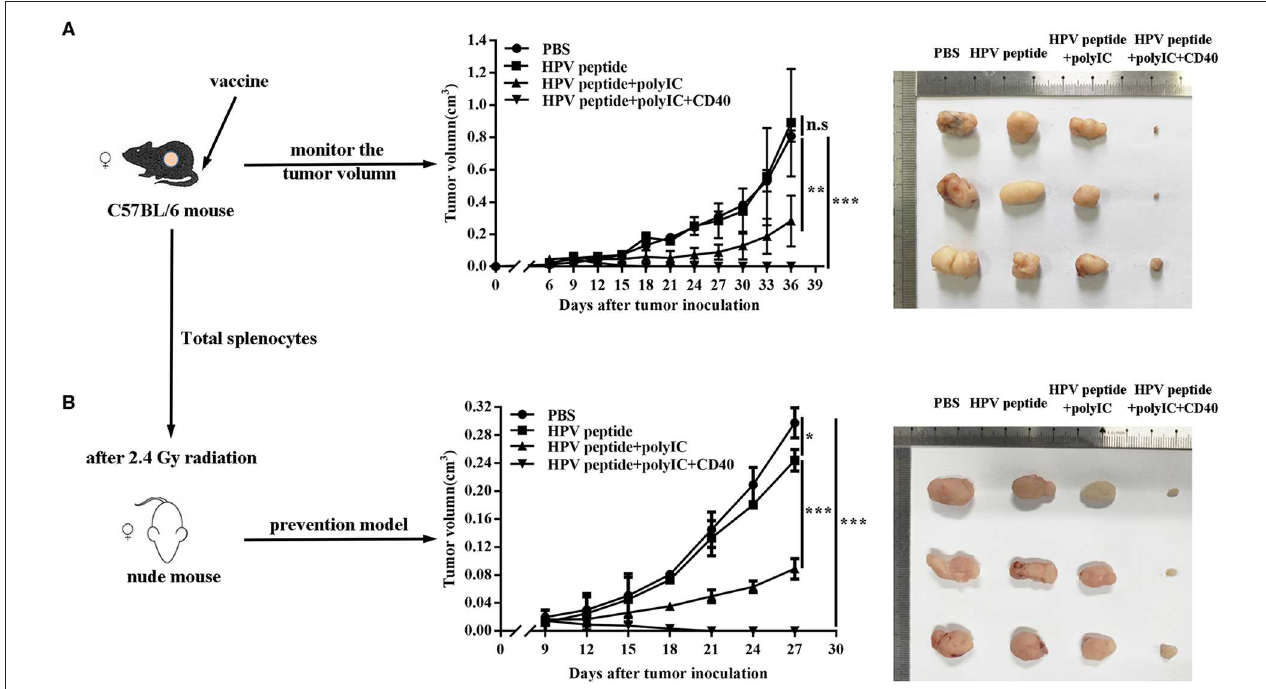
FIGURE 1 | Anti-tumor effects induced by different immunization. (A) Mice ( n = 3 per group) were inoculated (s.c.) with 1 × 10 6 TC-1 cells and vaccinated (i.v.) 6 days later with PBS, HPV16 E7 peptide alone, peptide plus polyIC, peptide and polyIC plus α CD40 mAb. (B) In the preventive model, nude mice after 2.4Gy radiation were injected with 10 million of total splenocytes of the immunized mice when TC-1 tumor appeared. Tumor growth was measured (two opposing diameters) and recorded once every 3 days. Data shown represent three independent experiments with similar results. * p < 0.05, ** p < 0.01, *** p < 0.001, n.s, p >